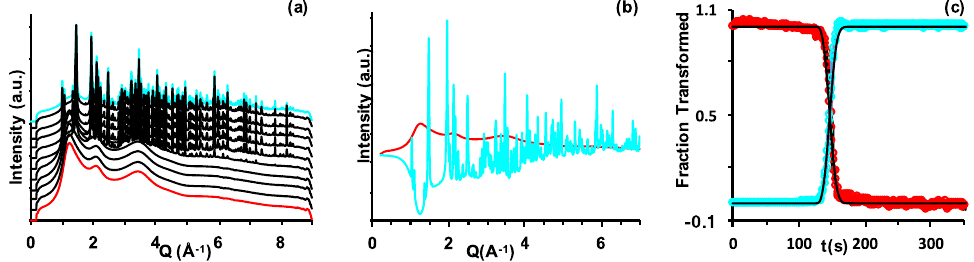
Figure 1. Bulk sample analysis of TtXRD measurement of the crystallization of [Zn(OH 2 ) 6 ][ZnCl 4 ] for a T iso = 238 K experiment. ( a ) Stack plot of 1-D diffraction patterns (3 s intervals plotted); ( b ) Time-independent basis vectors corresponding to the liquid (red) and crystalline (cyan) diffraction patterns; ( c ) Time-dependent basis vectors demonstrating the disappearance of liquid diffraction (red) and appearance of crystalline (cyan) diffraction, fit to the Kolmogorov, Johnson, Mehl, Avrami (KJMA) model (black line).